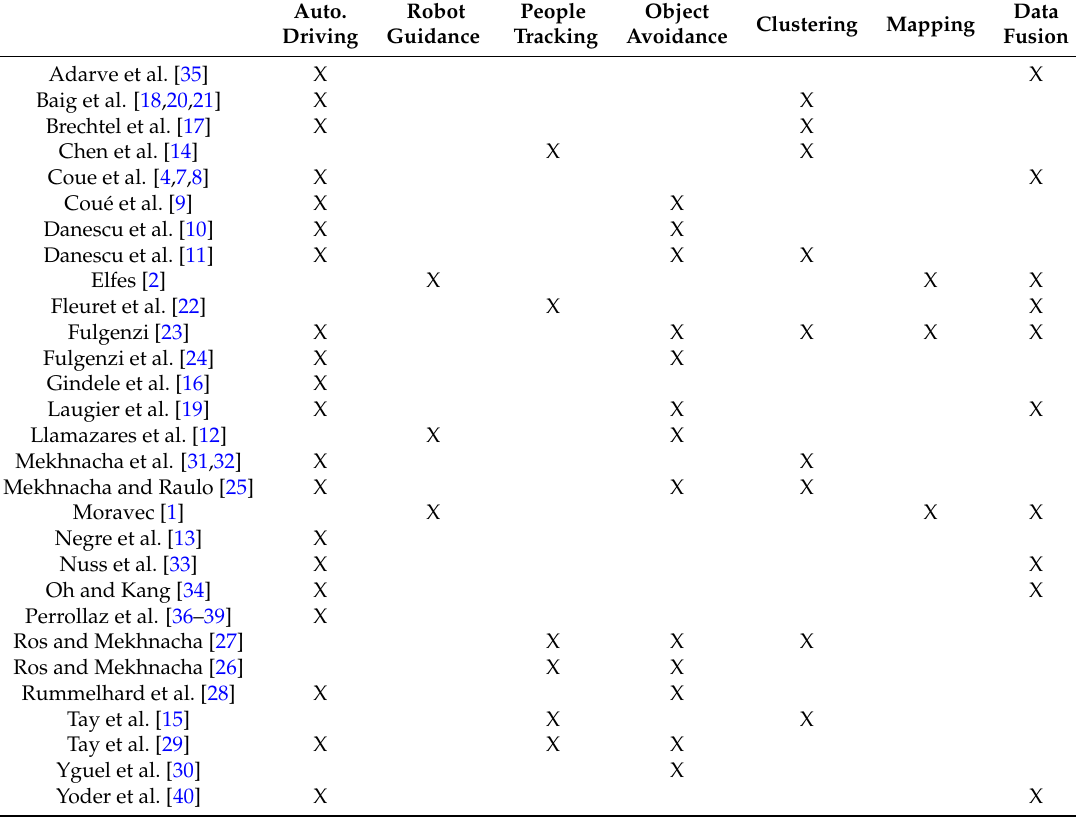
Table 2. Use cases of Bayesian Occupancy